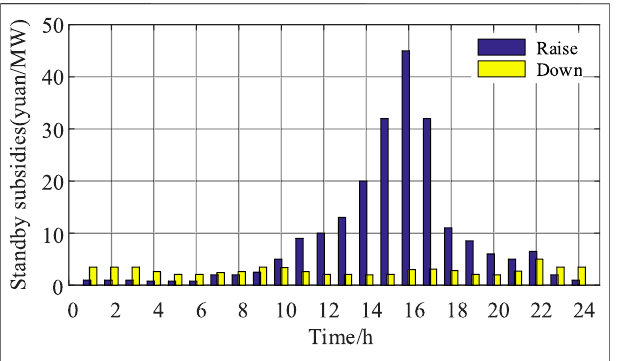
FIGURE 5 | ES reserve compensation price.